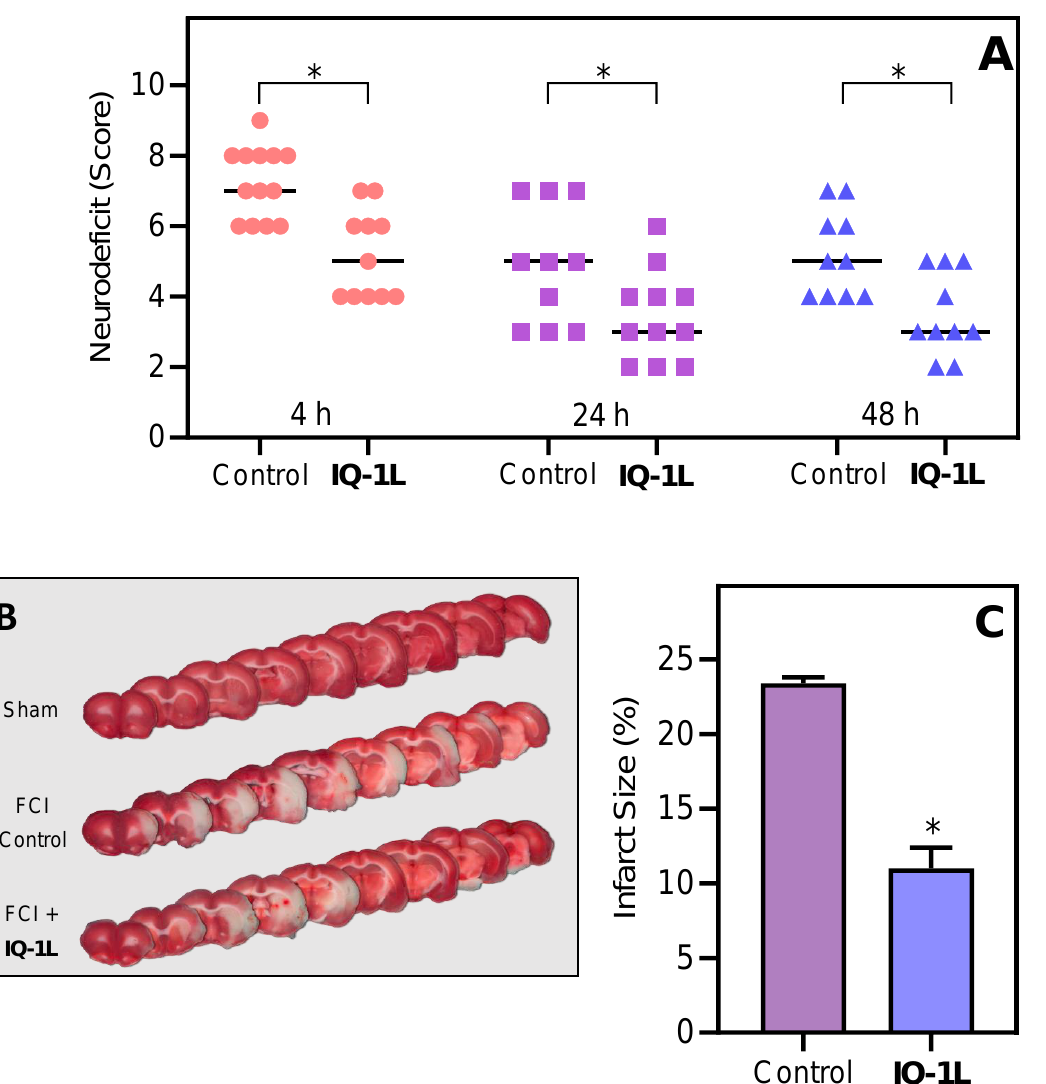
Figure 6. Effects of IQ-1L on neurological deficit 4, 24, and 48 h after FCI ( A ) and infarct size in rat brains 48 h after FCI ( B , C ). White areas represent the infarct regions in sections of representative samples of stained brain sections from rats sacrificed 48 h after FCI ( B ). * p < 0.05: as compared with control animals (FCI without IQ-1L treatment).